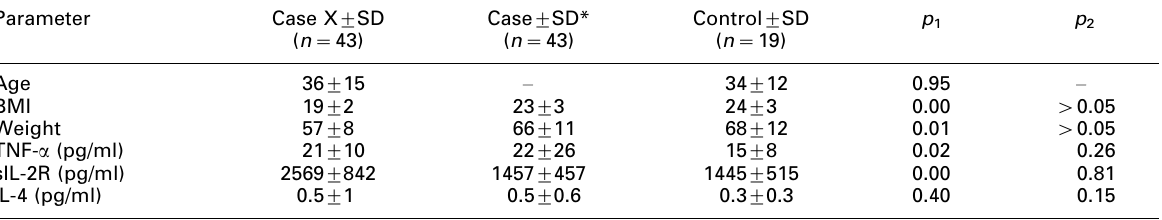
Table 2. Age, weight, body mass index (BMI), TNF- a and s IL 2R in controls and patients before and after chemotherapy